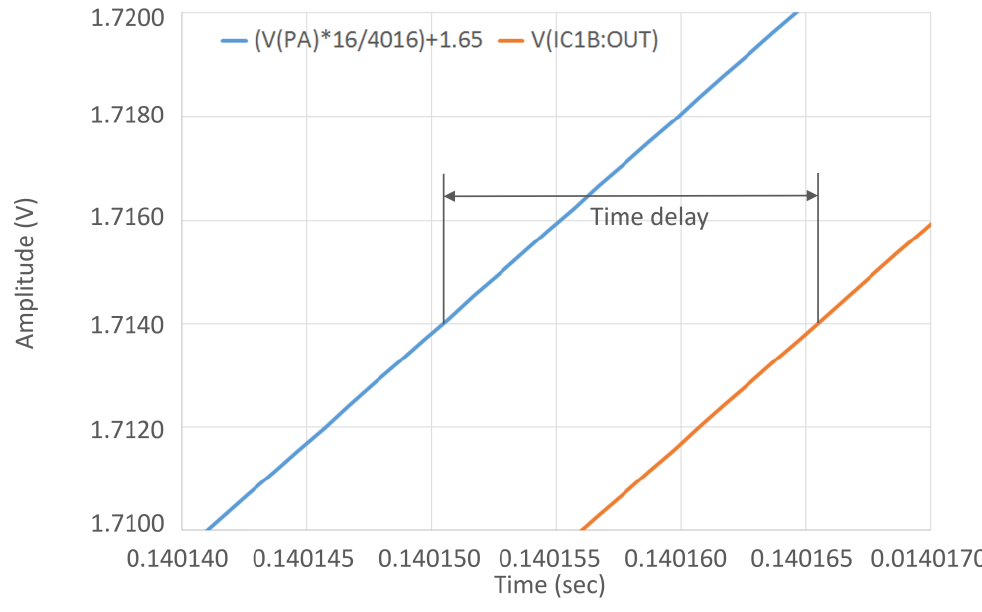
Figure 13. Line voltage circuit simulation delay.